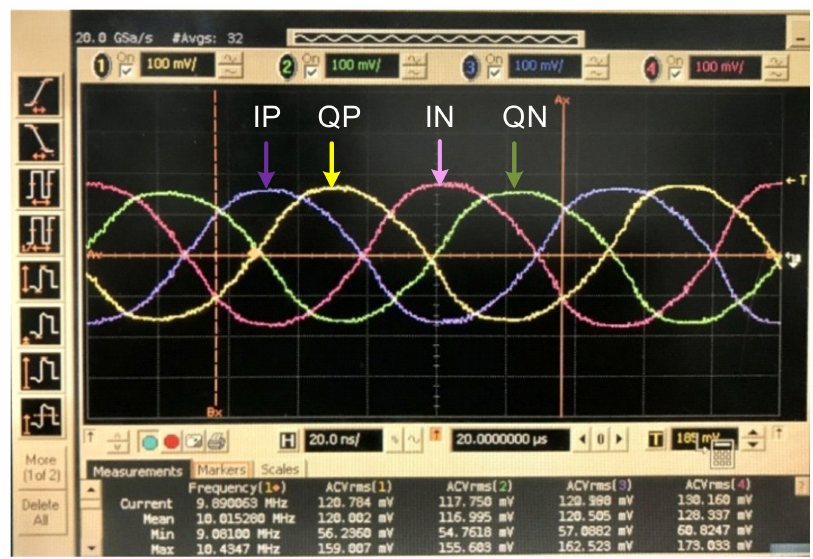
Figure 15. I/Q waveform measurement results at high gain mode of 60 GHz CMOS I/Q